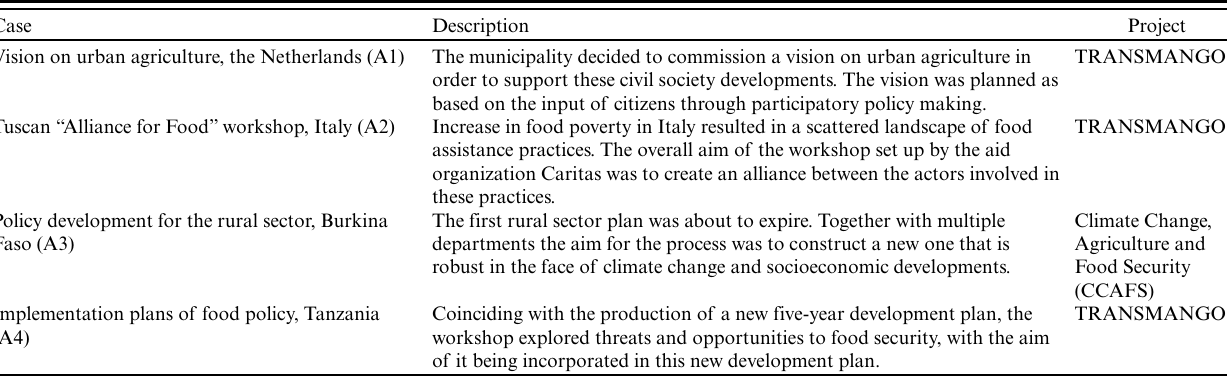
Table 2 . Overview of the foresight cases used for the analysis of the role of foresight in transformative